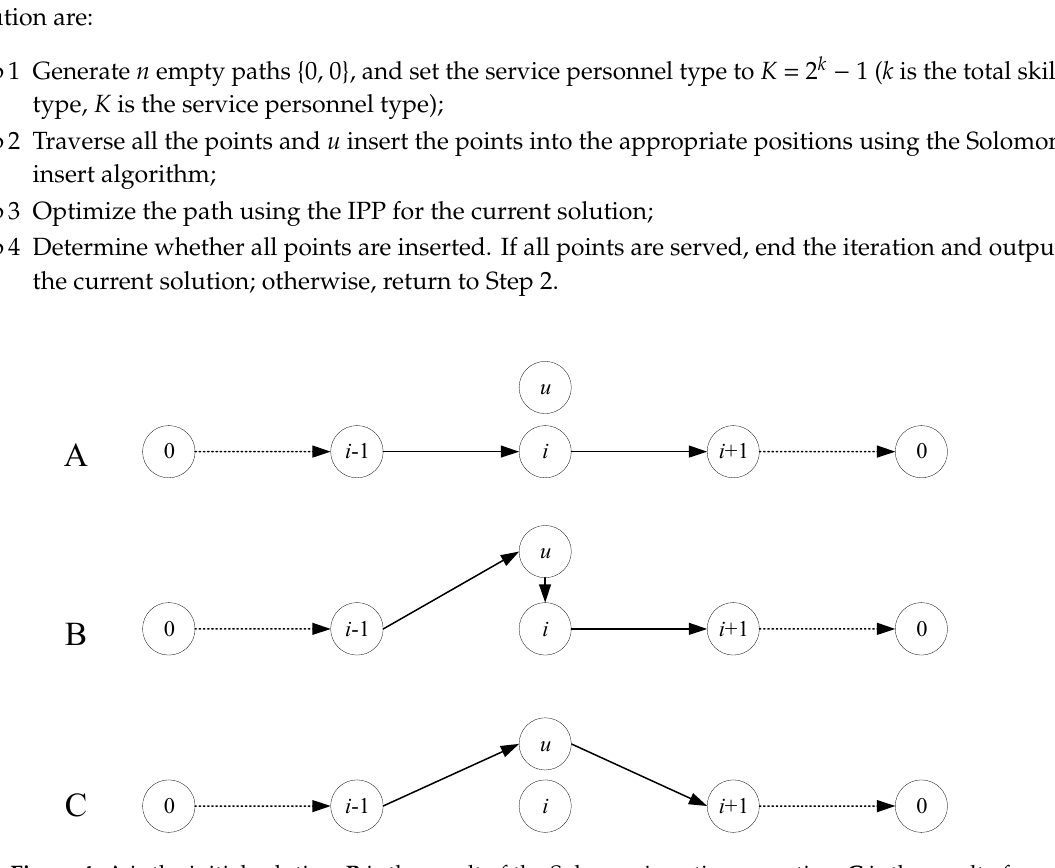
Figure 4. A is the initial solution, B is the result of the Solomon insertion operation, C is the result of the